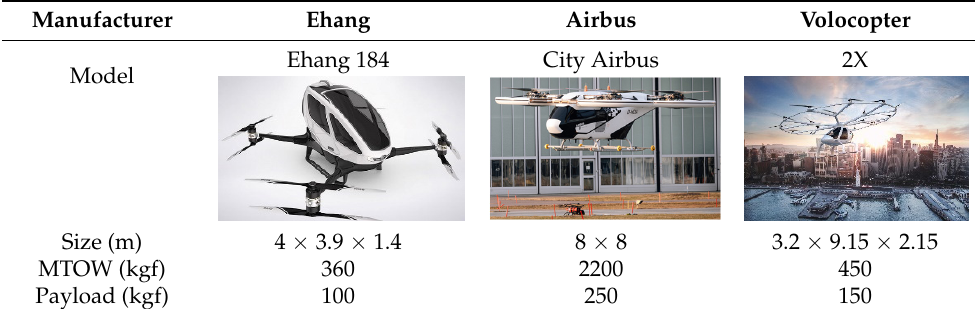
Table 3. Specifications of multicopter type heavy-lift eVTOL.